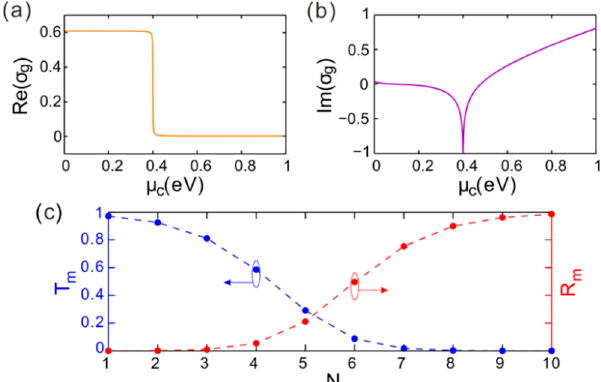
Figure 5. ( a , b ) The real and imaginary parts of surface conductivity of graphene, respectively. ( c ) The transmittance and reflectance of the defective mode (DM) varying with the Bragg periodic number N .